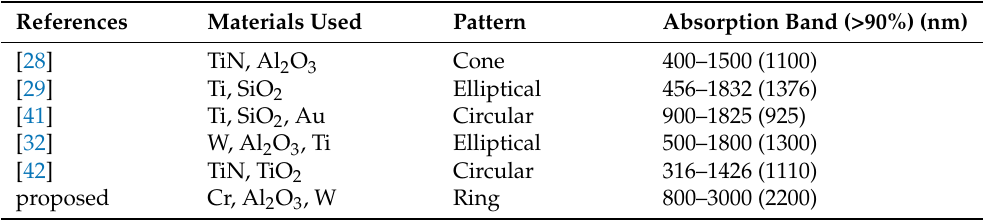
Table 1. Comparisons of the designed absorber with previous